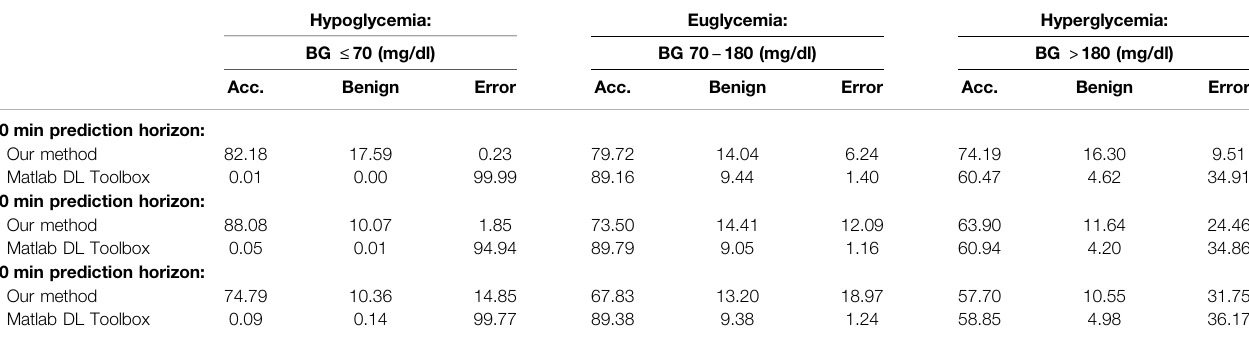
TABLE 8 | Average PRED-EGA scores (in percent) for different prediction horizons on dataset J , with training data selected from dataset D . Hypoglycemia: